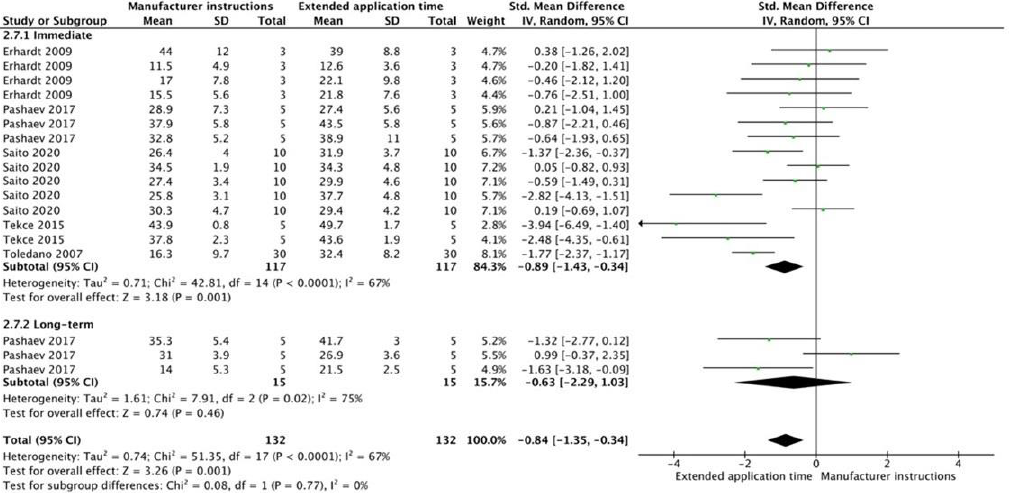
Figure 9. Forest plot showing the bond strength values when the adhesive was applied with an extended time application